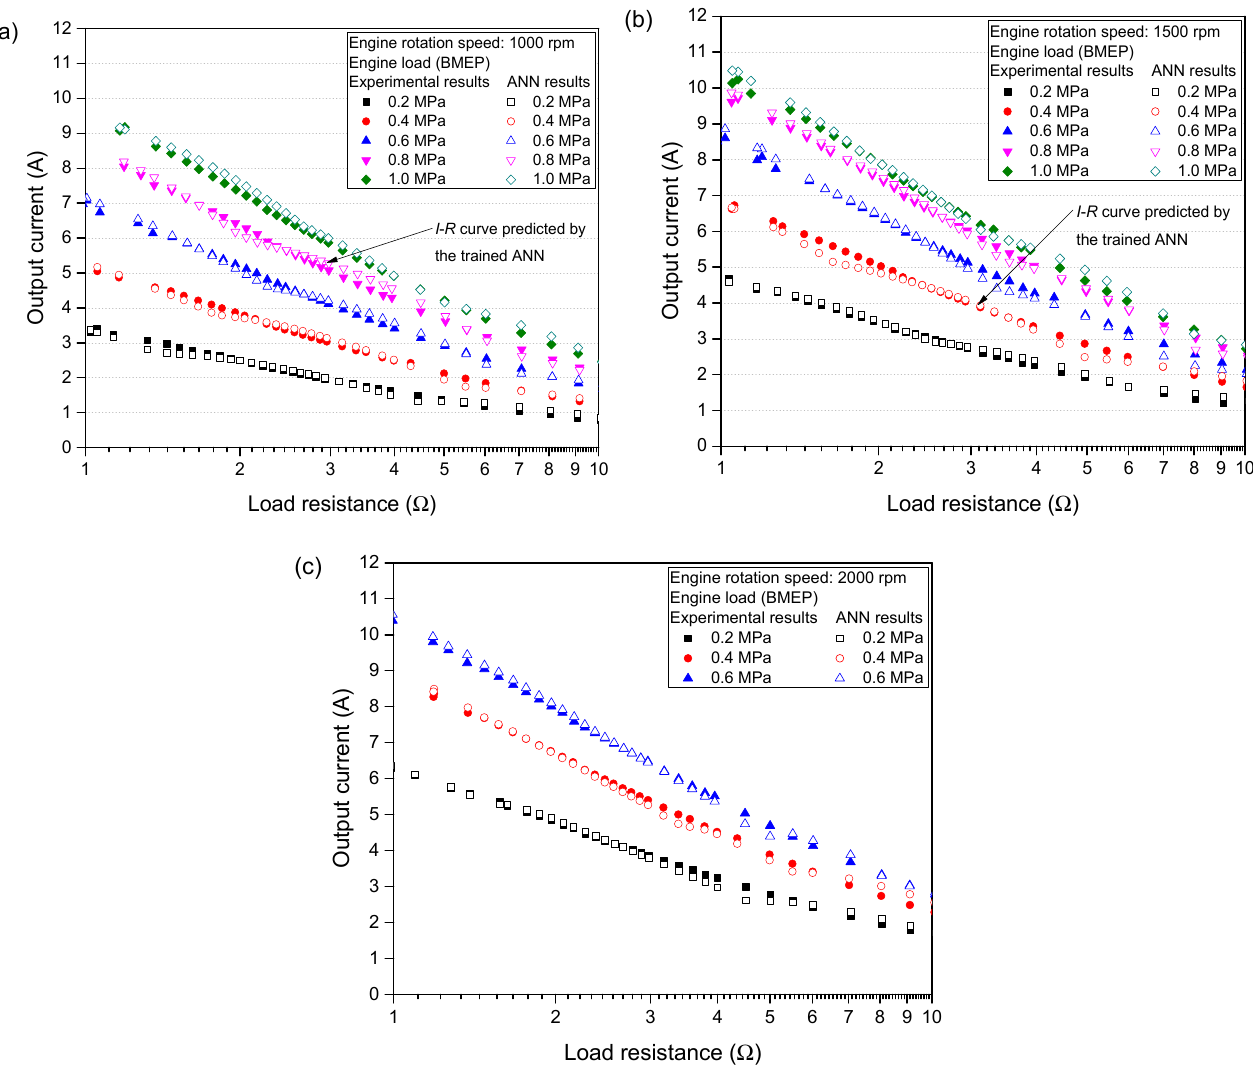
Figure 4. I–R curves obtained through experiments and ANN training and prediction for ( a ) engine rotation speed of 1000 rpm under five different engine loads, ( b ) engine rotation speed of 1500 rpm under five different engine loads, and ( c ) engine rotation speed of 2000 rpm under three different engine loads.